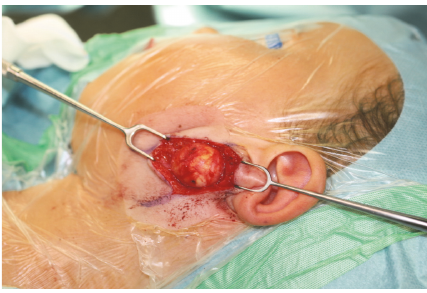
Figure 3: The intraoperative impression suggested a benign lesion with a tight capsule without abnormal vascularization.